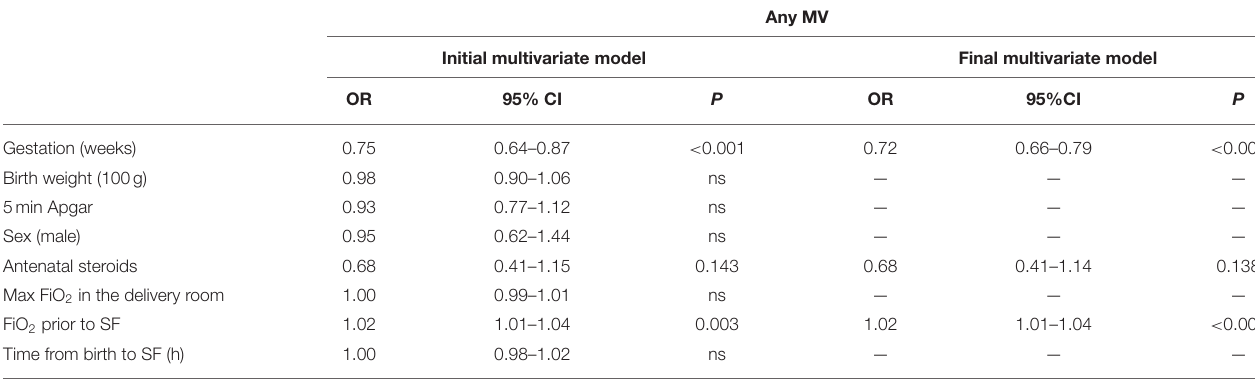
TABLE 3 | Logistic regression analysis examining variables influencing the need for MV at any time during